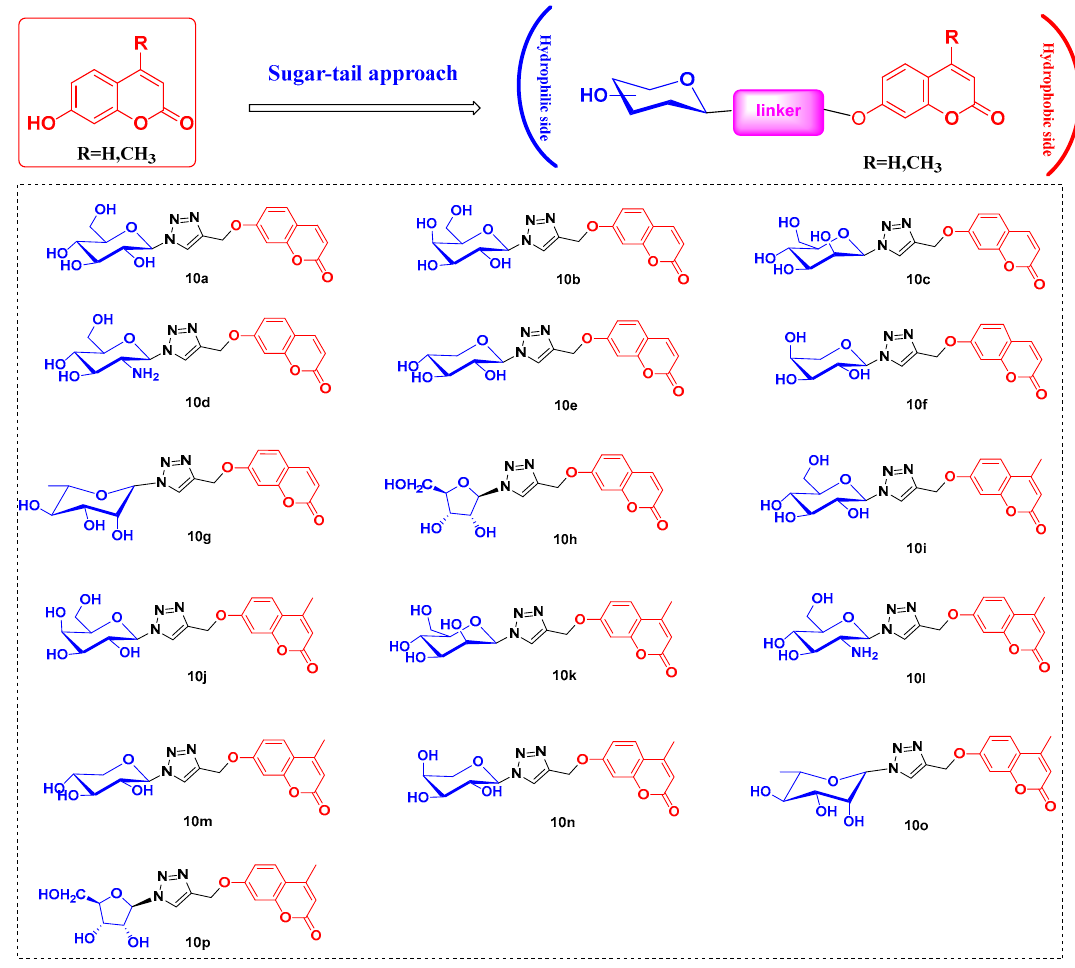
Figure 2. Rationale design of the target compounds. The sugar-tail scaffold and coumarin moiety were displayed with blue and red background, respectively.